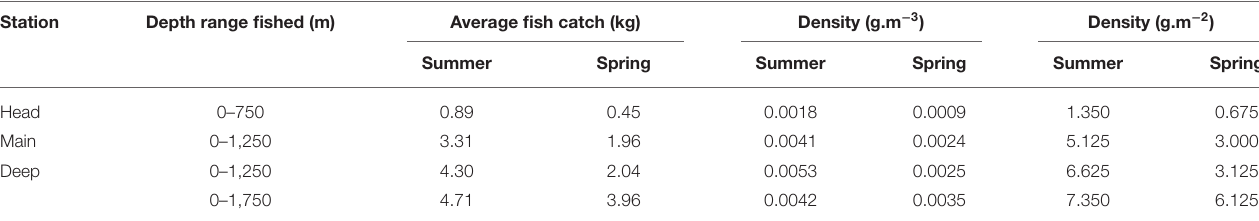
TABLE 3 | Average water-column fish catches and IYGPT-catchable biomass densities (by volume and sea-surface area) of the 19 principal species at the three principal stations, by season. Station